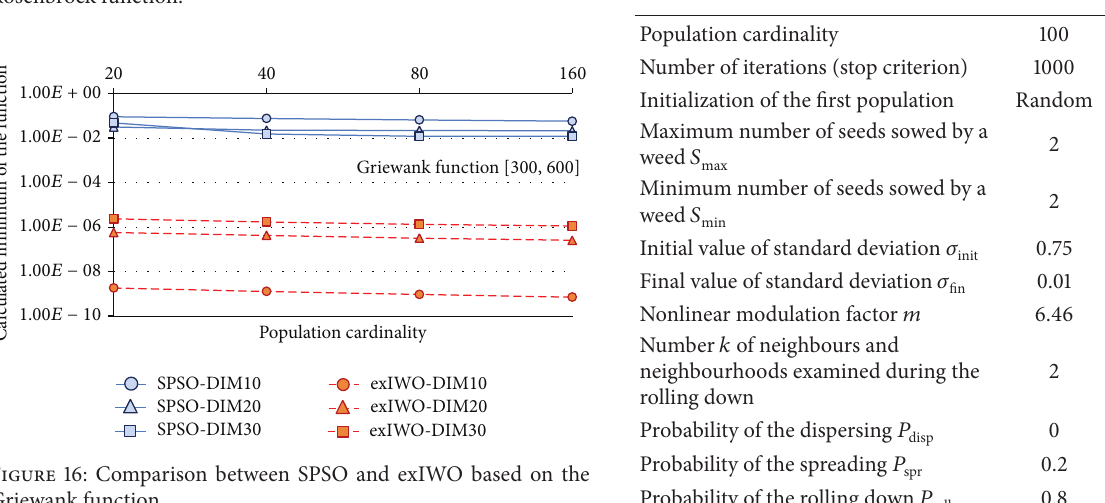
Figure 15: Comparison between SPSO and exIWO based on the Rosenbrock function.